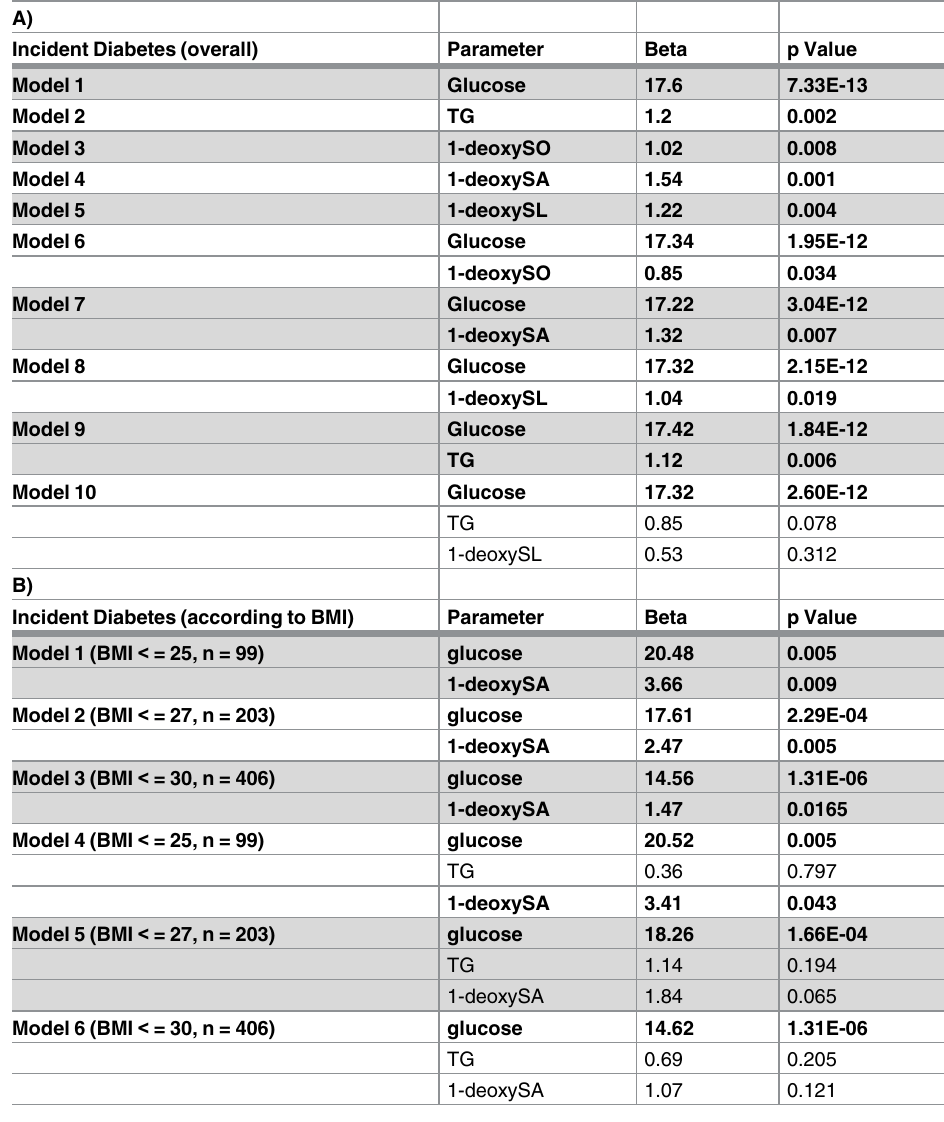
All models were adjusted for age, gender, BMI, lipid lowering drugs (y/n). Models at baseline were also adjusted for the metabolic syndrome (y/n). All variables were log transformed. Variables in bold are statistically significant (p < 0.05). SA, sphinganine;SO, sphingosine; TG,